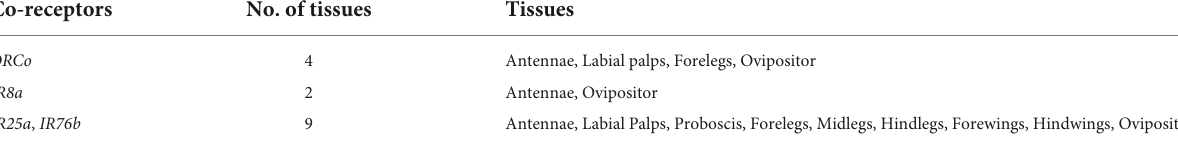
TABLE 3 Expression of co-receptor genes in different tissues.